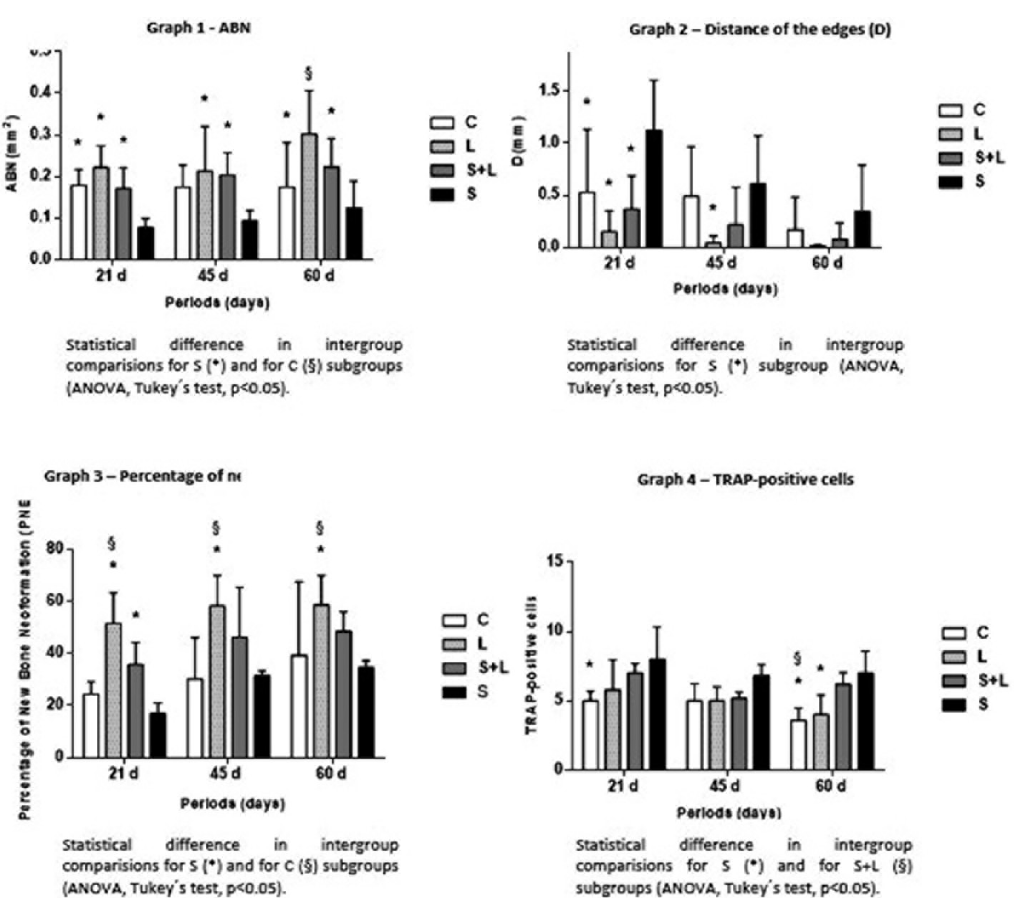
Figure 2- Graphics Graphic 1- Mean±SD of area of bone neoformation (ABN). Intergroup comparisons for all periods. *, significant difference compared to the S group at the same study time point (p<0.05). §, significant difference compared to the C group at the same study time point (p<0.05) Graphic 2- Mean±SD of distance of the edges (D). Intergroup comparison for all periods. *, significant difference compared to the S group at the same study time point (p<0.05) Graphic 3- Mean±SD of percentage of bone neoformation (PBNF). Intergroup comparison for all periods. *, significant difference compared to the S group at the same study time point (p<0.05); §, significant difference compared to the C group at the same study time point (p<0.05) Graphic 4- Mean±SD of TRAP-positive cells. Intergroup comparison for all periods. *, significant difference compared to the S group at the same study time point (p<0.05); §, significant difference compared to the S+L group at the same study time point